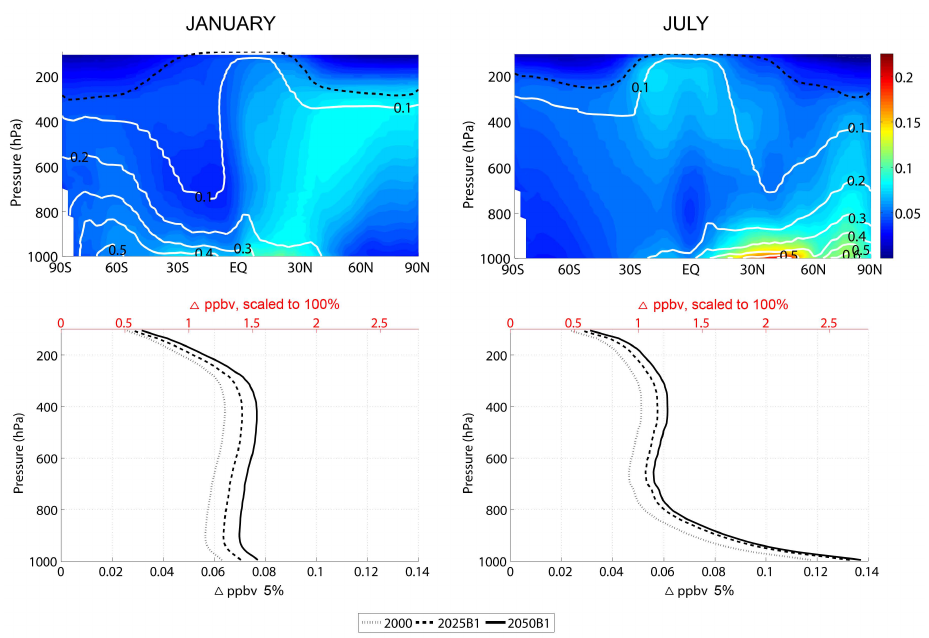
Fig. 9. Zonal mean perturbations of ozone ( 1 ppbv) during January (left) and July (right) for the 2050 B1 scenario (top) and as Northern Hemisphere average for all years (bottom). In the top figures, solid contour lines show the change relative to the BASE simulation while the dashed line indicates the tropopause. The color bar and the bottom x-axis show the impact caused by a 5% perturbation of ship emissions (simulations BASE – SHIP), while the red scales in the bottom figures are scaled up by a factor 20 from 5% to 100%.